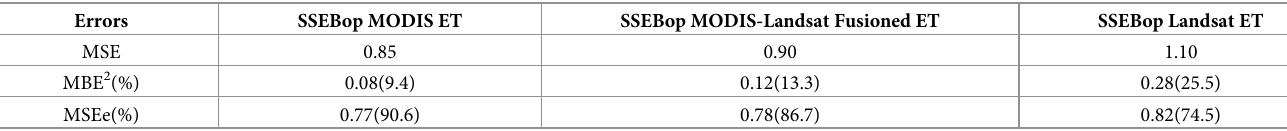
Table 2. The error statics for the ET estimated by the three methods.